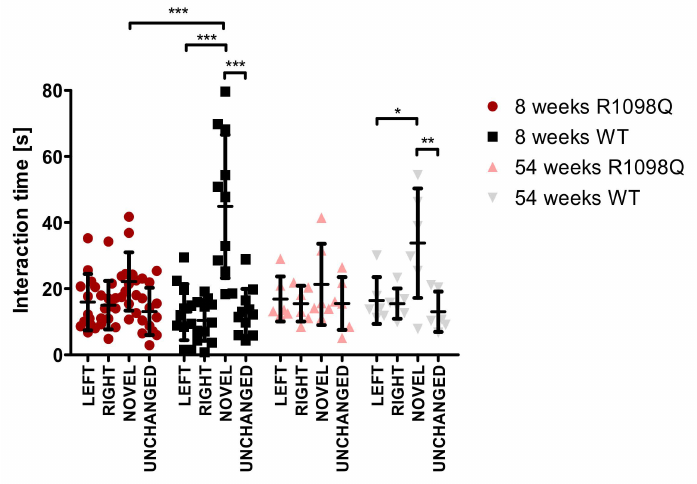
Figure 4. Novel object recognition test. During the first-day training session, two similar objects were used, marked “left” and “right”. On the second day session, one object was replaced by a new one and marked “novel”, while the other object remained the same and was marked “unchanged”. The test was performed on the 8-week-old group (WT, n = 11; R1098Q, n = 13) and the 54-week-old group (WT, n = 6; R1098Q, n = 6). Each point on the graph represents the interaction time of a single mouse with given objects. Error bars represent standard deviations (SD) with the mean interaction time for a given age group marked. The statistics were calculated using two-way ANOVA. Statistically significant differences between R1098Q and WT mice indicating the effect of the mutation on memory are marked with an asterisk (* p < 0.05, ** p < 0.01, and *** p < 0.001).